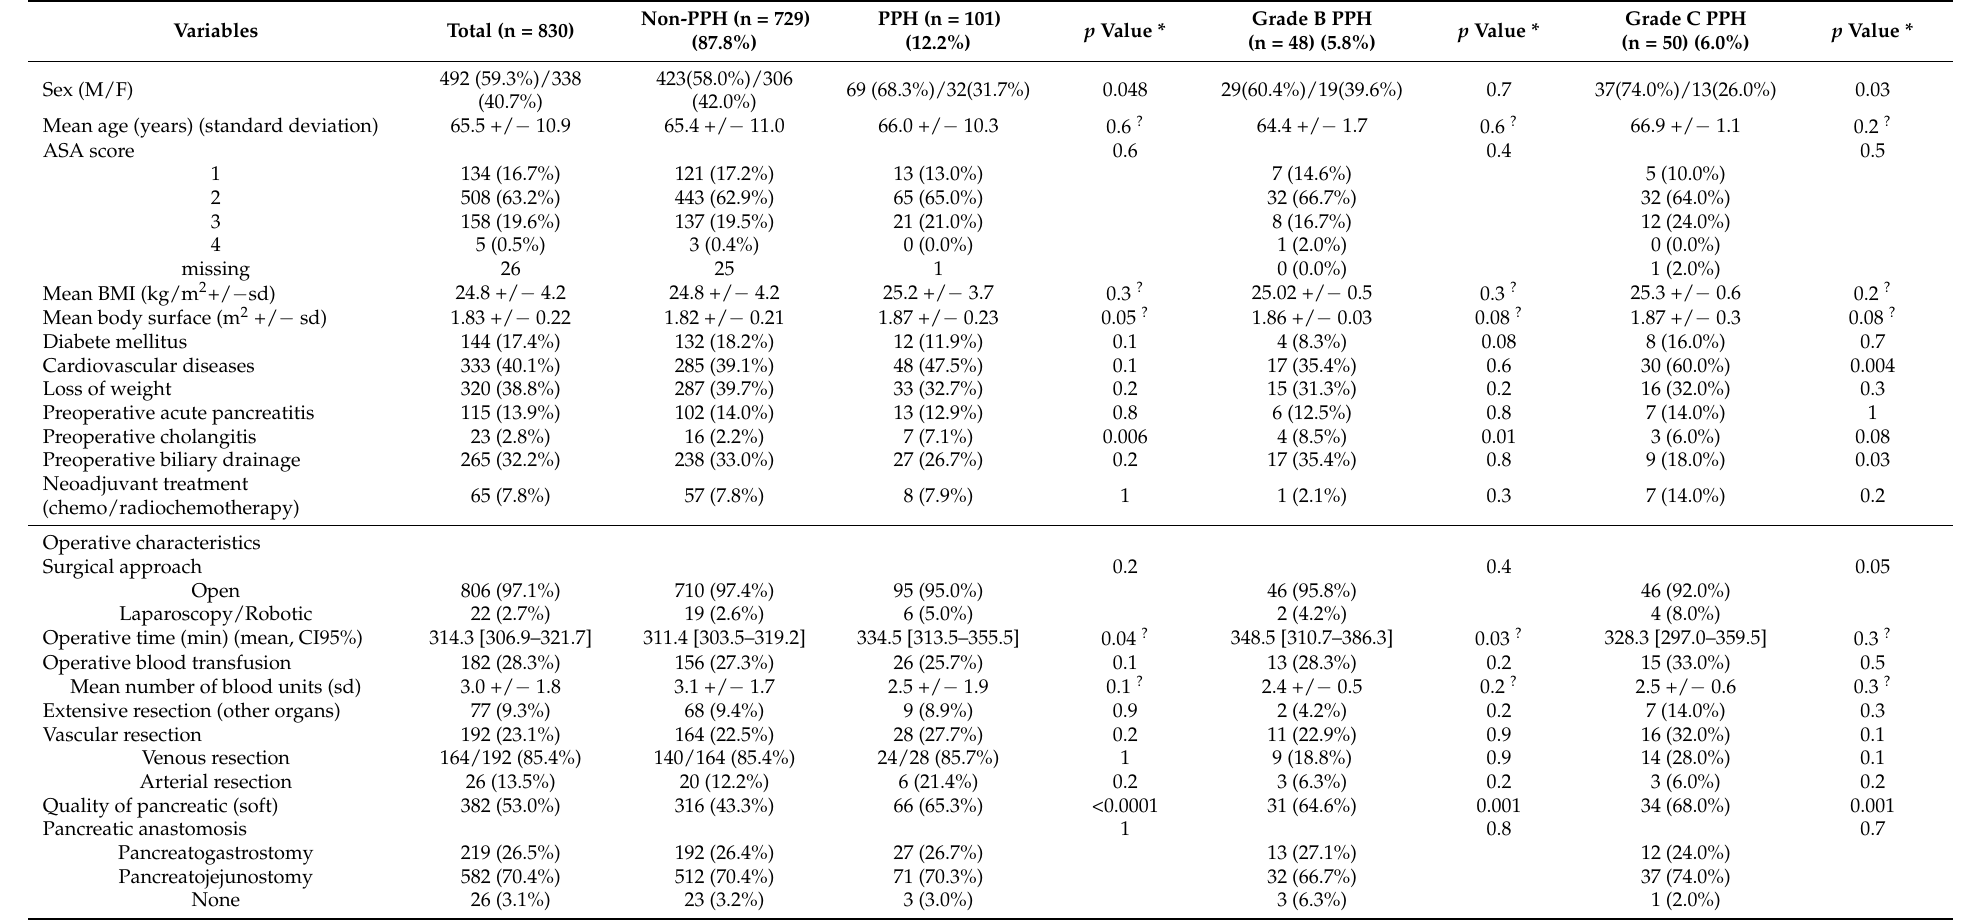
Table 1. Clinical and operative characteristics of the PPH (n = 101) and non-PPH (n = 729) groups (* Chi-squared test, ? Student’s t -test). Grade B and C PPH groups are compared to the non-PPH group (with only 3 patients, the grade A PPH group does not appear in the